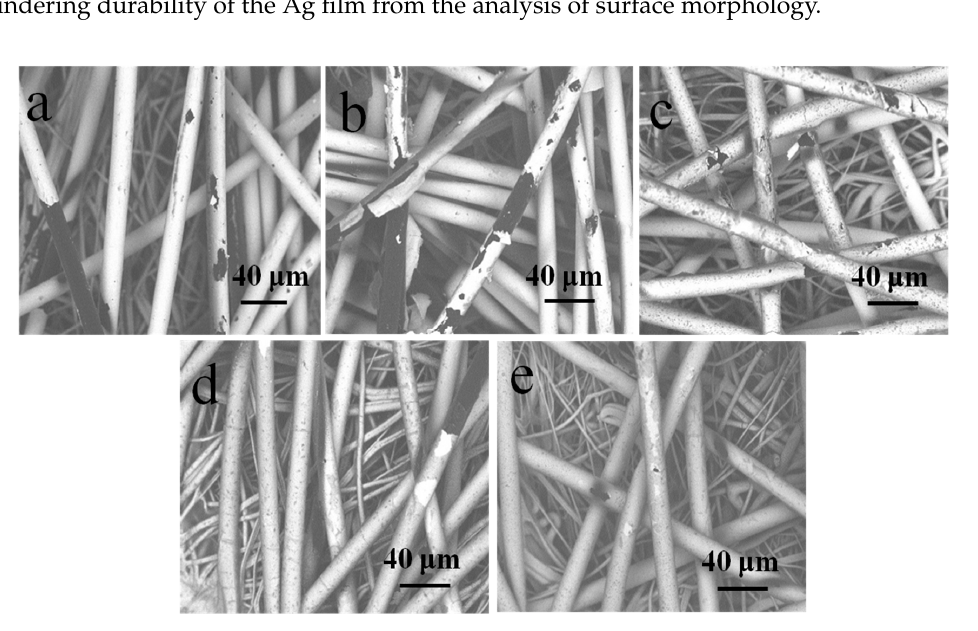
Figure 13. Surface morphology of samples after washing: ( a ) Ag-coated PP nonwoven; ( b ) PDA deposited (3 h) on the Ag-coated PP nonwoven; ( c ) PDA deposited (3 h) on the Ag-coated PP nonwoven; ( d ) PDA deposited (3 h) on the Ag-coated PP nonwoven; and ( e ) PDA deposited (3 h) on the Ag-coated PP nonwoven.